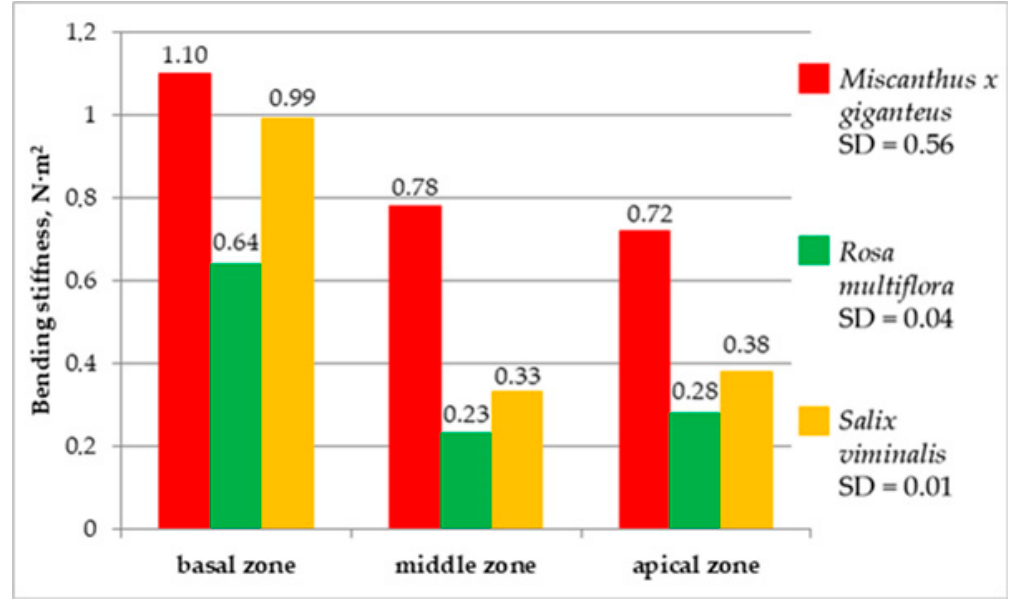
Figure 14. The average bending sti ff ness of the investigated